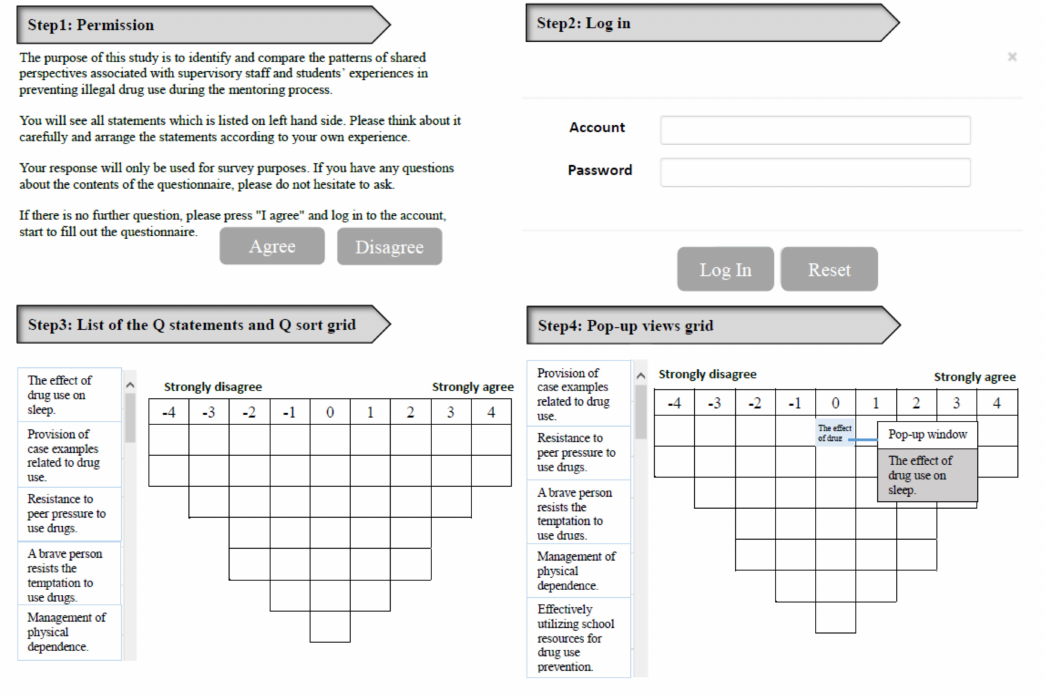
Figure 1. Illustration of online Q sort procedure. The content of this interface was translated into English; the original interface was in